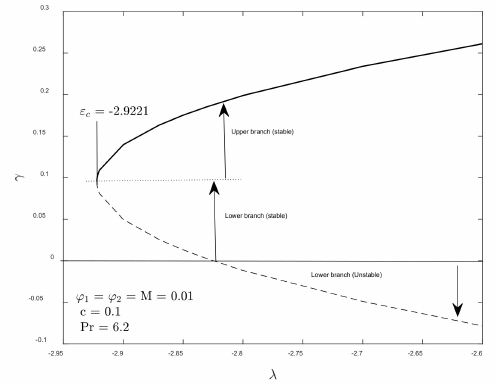
Figure 12. Minimum eigenvalues γ for selected values of λ